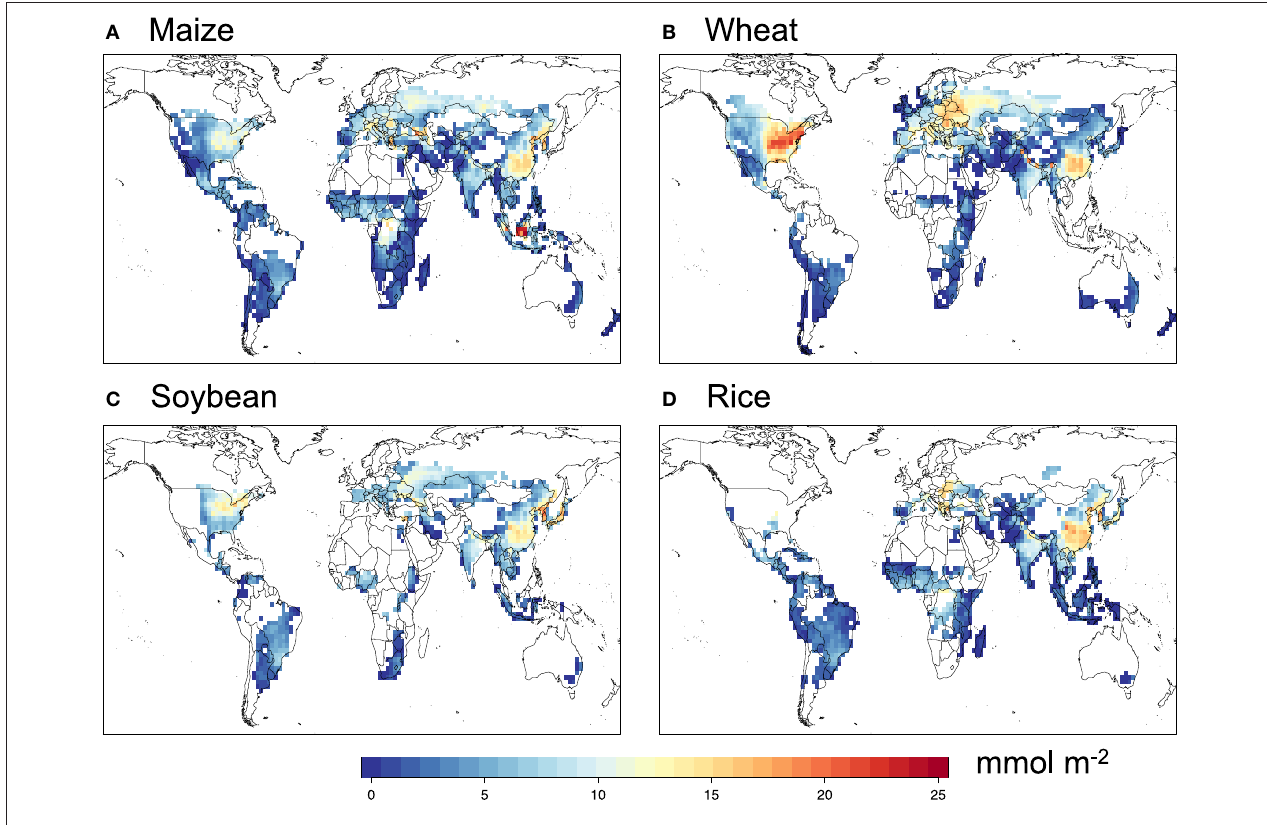
FIGURE 2 | Simulated POD 3 for (A) maize, (B) wheat, (C) soybean, and (D) rice with the DO 3 SE method.